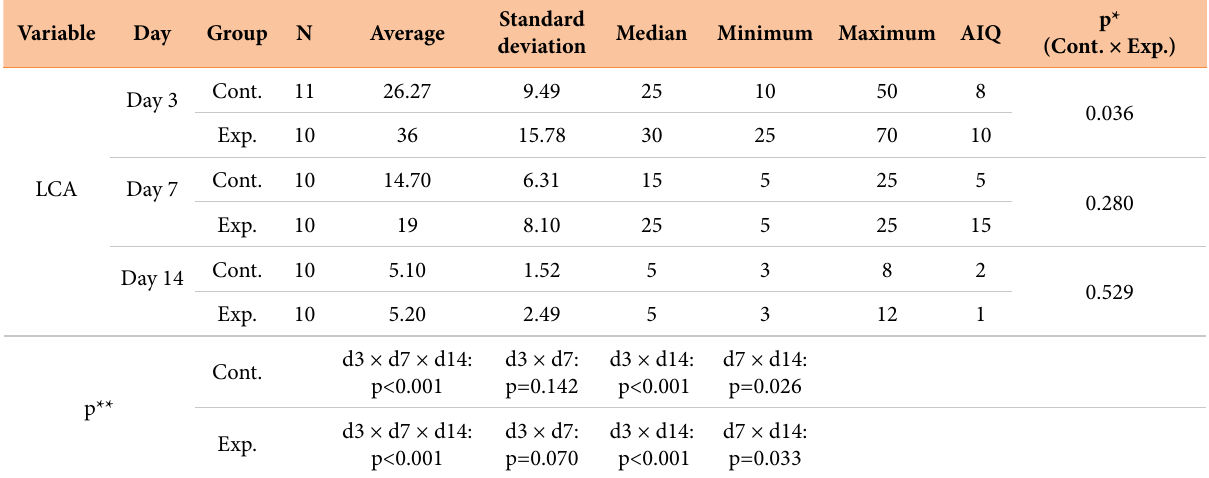
Table 2 - Mean number of leukocytes in 10 fields (marked by